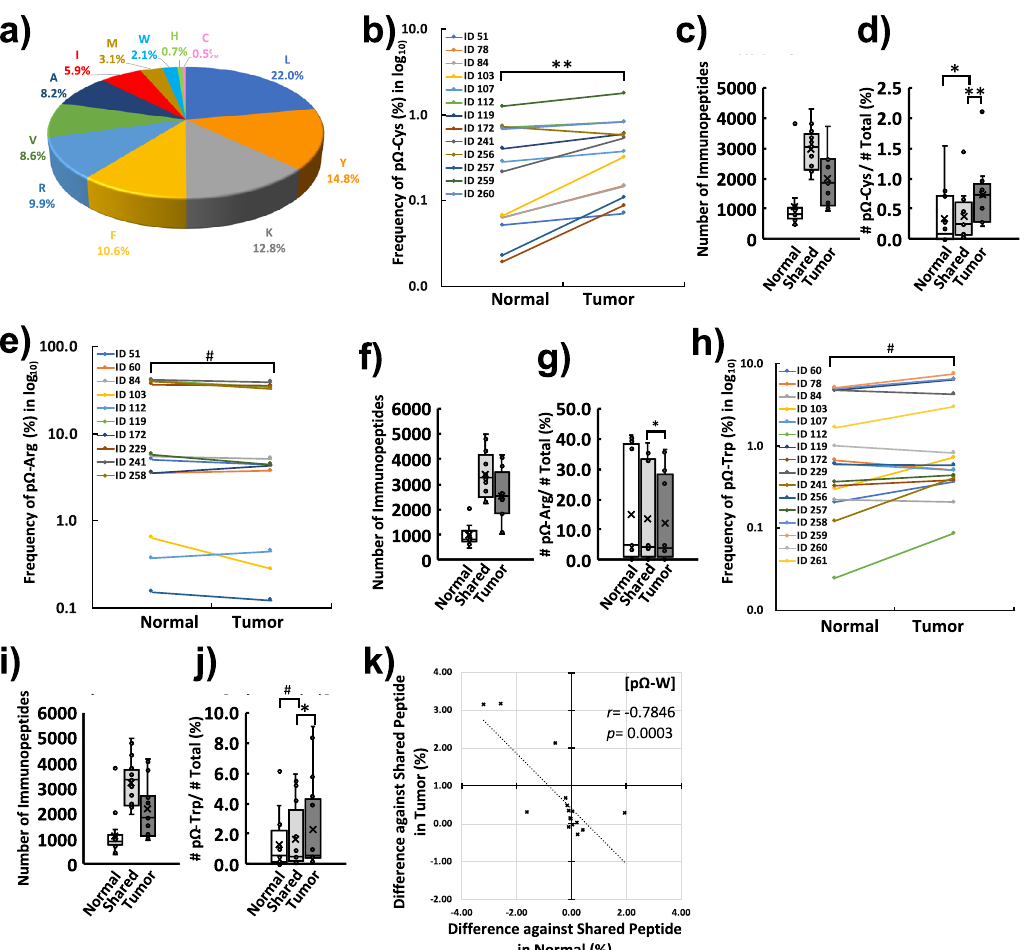
Fig. 3 The CRC immunopeptidome, neoantigens directly identi fi ed from tissues and the cancer-speci fi c pro fi ling of HLAp by global immunopeptidomics analysis. a Frequency of amino acid usage at the C-terminus (p Ω ) of immunopeptides identi fi ed from CRC samples. Immunopeptides eight to 12 amino acids in length (total 44,648) and exceeding 0.5% frequency are depicted in the pie chart. b A trend-shift of cysteine at p Ω (p Ω -Cys) in the tumor immunopeptidome within CRC patients. Only p Ω -Cys immunopeptide-identi fi ed samples ( n = 13) are depicted. The percentile frequency is depicted with a logarithmic (log10) vertical axis. ** p < 0.01 by paired Student ’ s t test. c The box plot indicates the number of immunopeptides in the group of normal-exclusive, shared and tumor-exclusive labeled with Normal, Shared and Tumor, respectively. d The box plot indicates the frequency of p Ω -Cys immunopeptides in each groups. Signi fi cance of frequency is depicted as * p < 0.05, ** p < 0.01 by Student ’ s paired t test. e A trend-shift of arginine at p Ω (p Ω -Arg) in the tumor immunopeptidome within CRC patients. A result from p Ω -Arg immunopeptide-identi fi ed samples ( n = 12) is depicted. The percentile frequency is depicted with a logarithmic (log10) vertical axis. The normal-exclusive population includes more p Ω -Arg immunopeptides. # p = 0.058 by paired Student ’ s t test. Further breakdown of immunopeptides by exclusivity revealed signi fi cantly lower p Ω -Arg immunopeptides in the tumor-exclusive population. f The box plot indicates the number of immunopeptides in the group of normal-exclusive, shared and tumor-exclusive labeled with Normal, Shared and Tumor, respectively. g The box plot on the right indicates the frequency of p Ω -Arg immunopeptides in each groups. * p < 0.05 by paired Student ’ s t test. h A trend shift of tryptophan at p Ω (p Ω -Trp) in the tumor immunopeptidome within CRC patients. Only p Ω -Tryp immunopeptide- identi fi ed samples ( n = 16) are depicted. The percentile frequency is depicted with a logarithmic (log10) vertical axis. The tendency of frequency is depicted as # p = 0.074 by paired Student ’ s t test. Further breakdown of immunopeptides by exclusivity revealed the tendency of increased frequency of p Ω -Trp immunopeptides in the tumor-exclusive population. i The box plot indicates the number of immunopeptides in the group of normal-exclusive, shared and tumor-exclusive labeled with Normal, Shared and Tumor, respectively. j The box plot on the right indicates the frequency of p Ω -Trp immunopeptides in each groups. * p < 0.05, # p = 0.080 by Student ’ s paired t test. k Pearson correlation coef fi cient ( r ) revealed the negative correlation of the frequency of p Ω - Trp immunopeptides between normal-exclusive and tumor-exclusive samples from identical patients. The lower the frequency of p Ω -W was in the normal- exclusive population, the higher the frequency of p Ω -W was in the tumor-exclusive